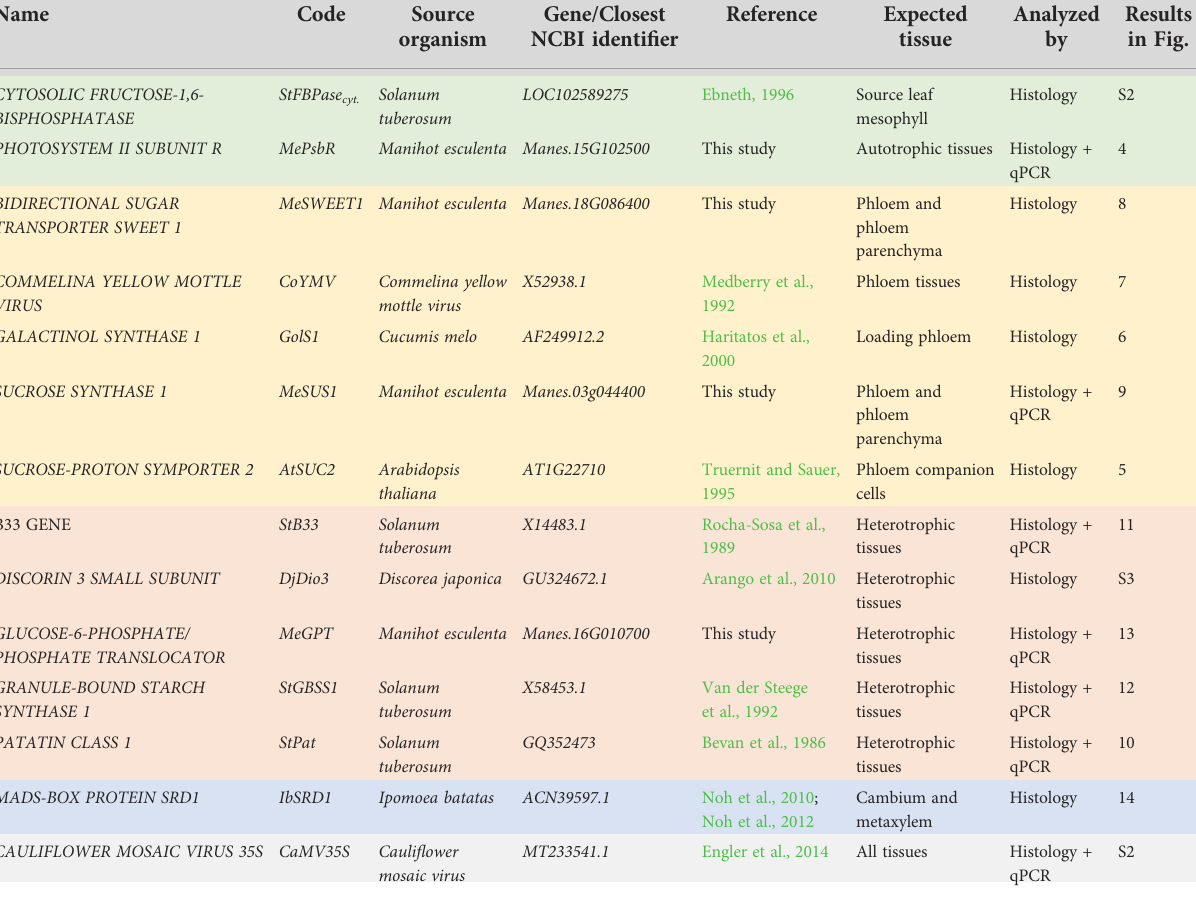
TABLE 2 Summary of 14 promoters assayed via their GUS expression and/or GUS staining pattern in transgenic cassava plants grown in the